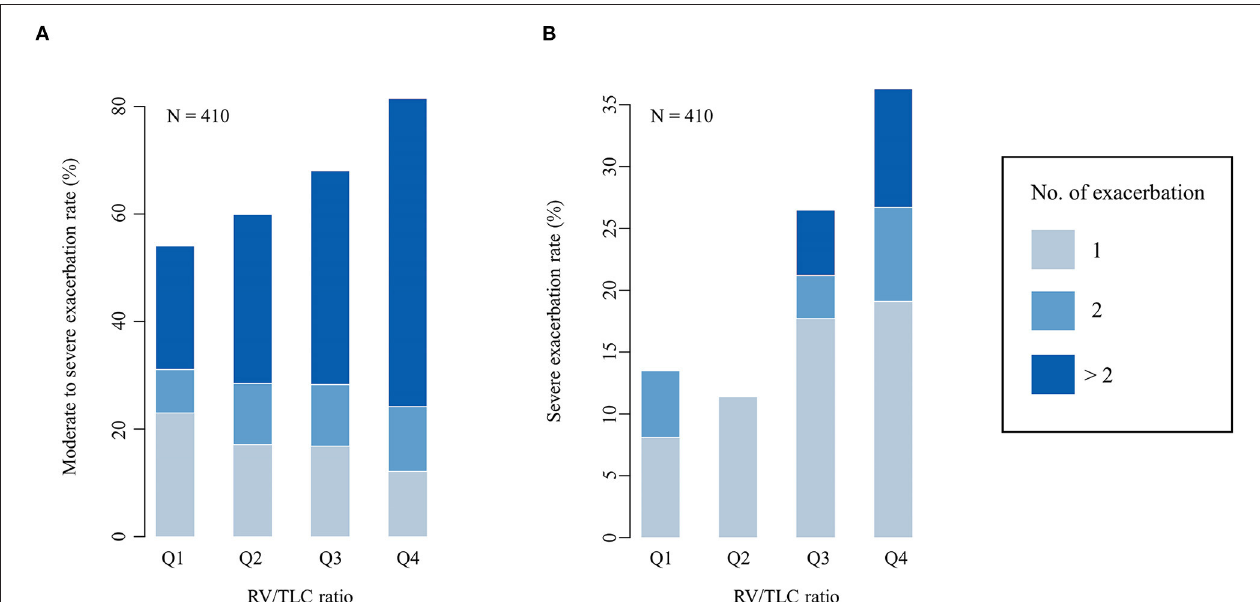
TABLE 2 | Incidence of COPD exacerbation during three years according to the percent-predicted FEV 1 and the RV/TLC ratio.